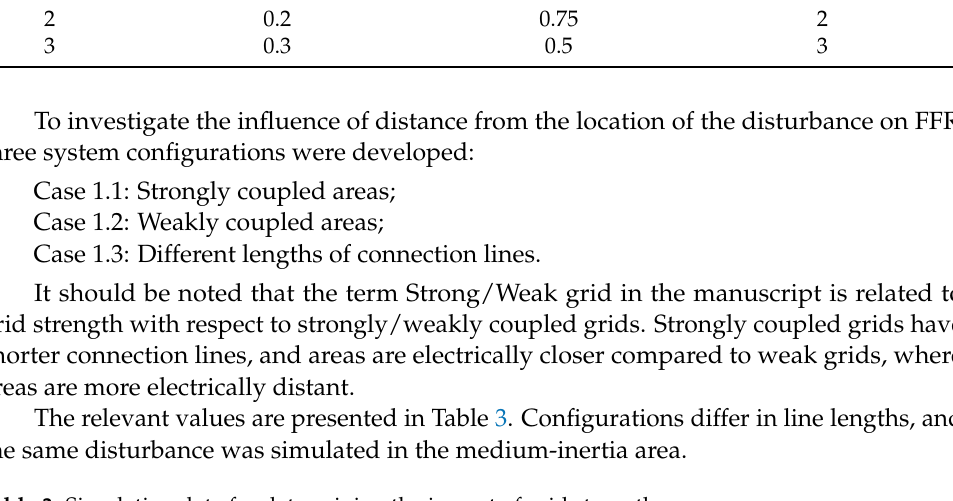
Table 3. Simulation data for determining the impact of grid